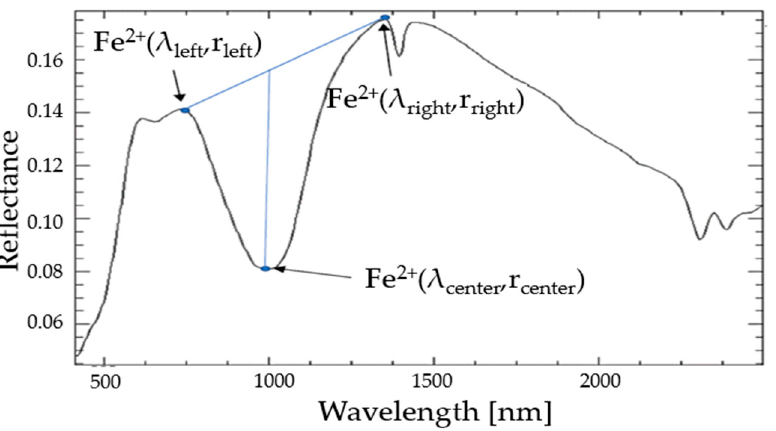
Figure 7. Schematic illustration of the MIFD 1000 parameter estimation on a spectrum example of a peridotite sample (analogous to MIFD 650 ).